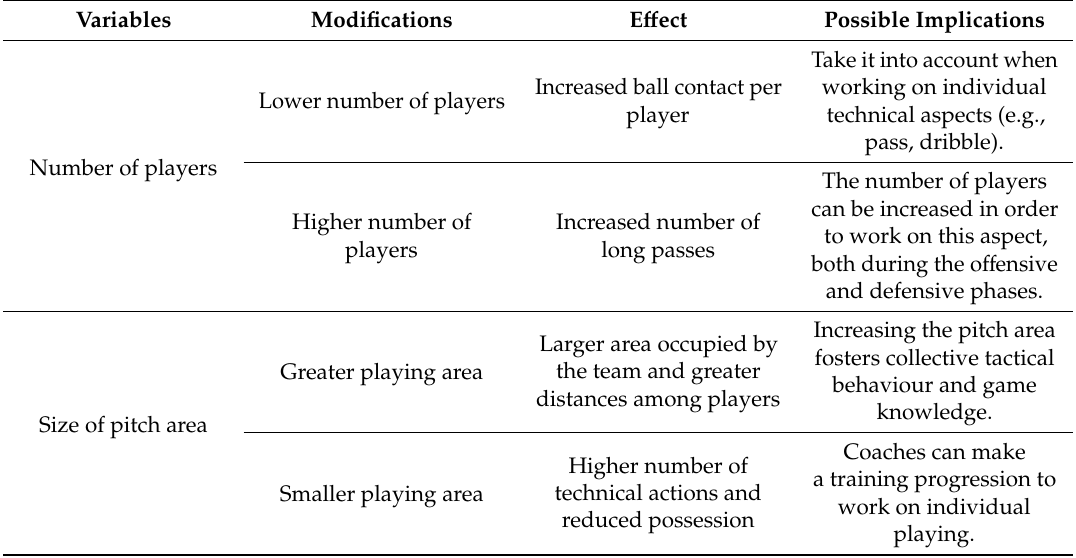
Table 5. Summary and possible practical implications of the studies analysed with regard to technical–tactical